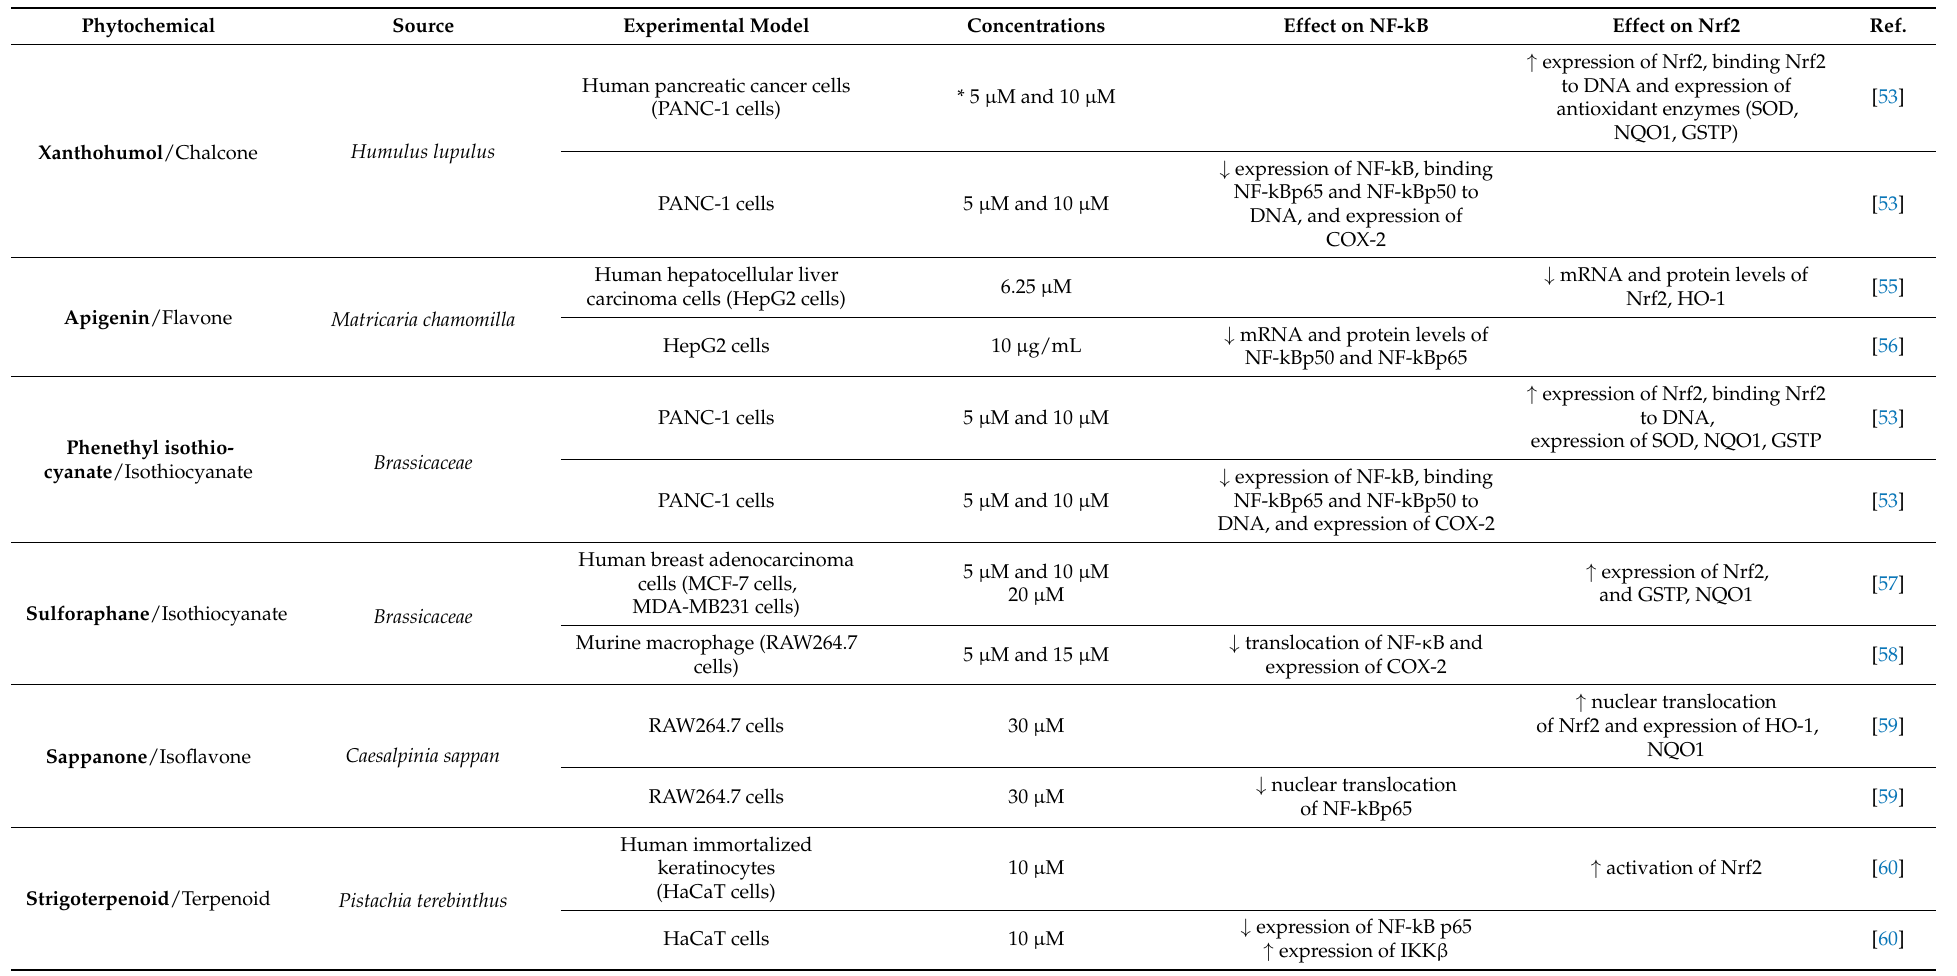
Table 1. Modulation of Nrf2 and NF-kB pathways by selected phytochemicals in vitro and in vivo